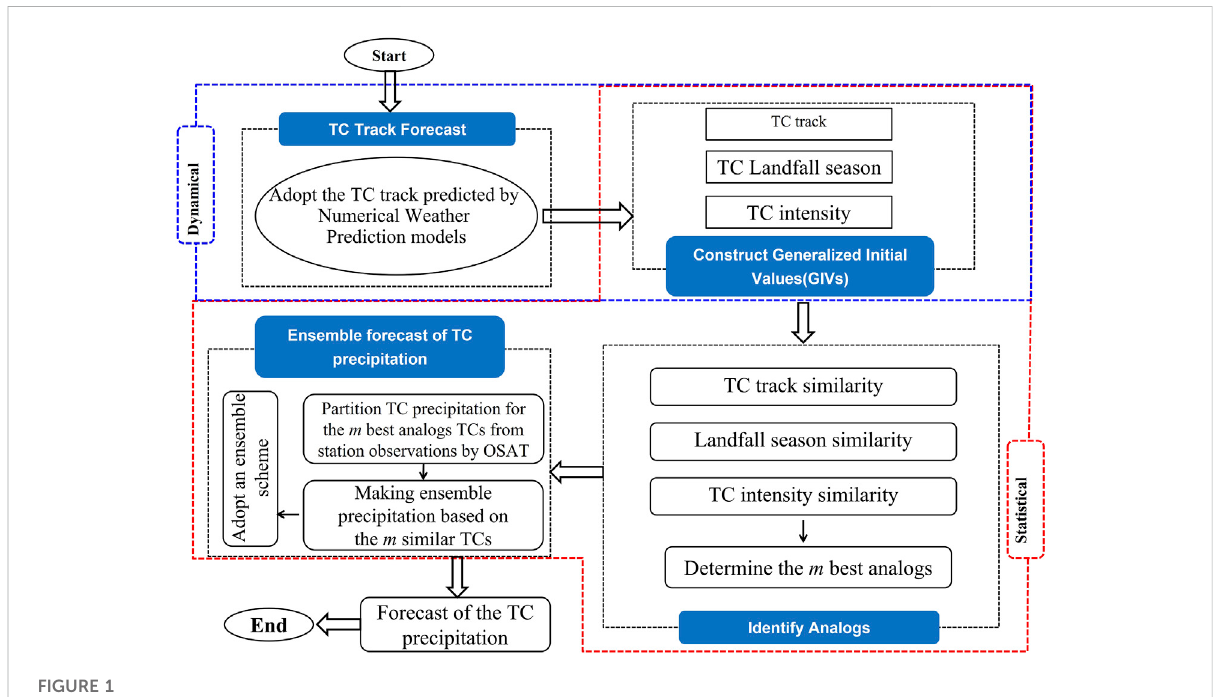
FIGURE 1 Flowchart of the DSAEF_LTP